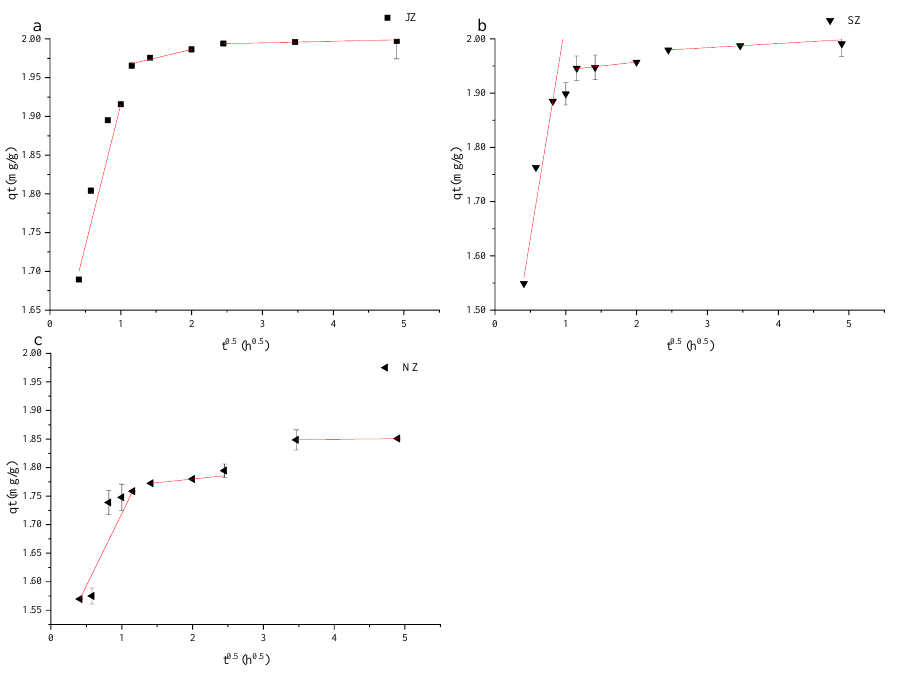
Figure 7. Fitting diagram of the Cd diffusion model by modified zeolites, ( a ) JZ and ( b ) SZ, and ( c )